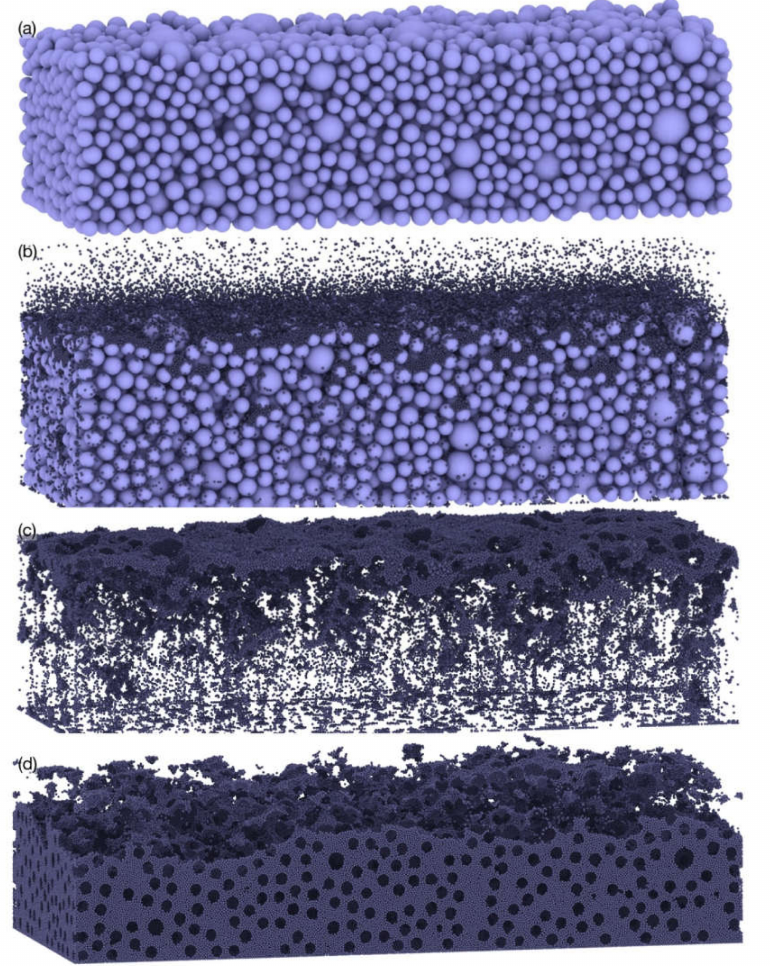
Figure 7. Structure of bed: ( a ) gravel-bed structure; ( b ) fine sediment infiltration; ( c ) fine sediment distribution—bridging; ( d ) fine sediment